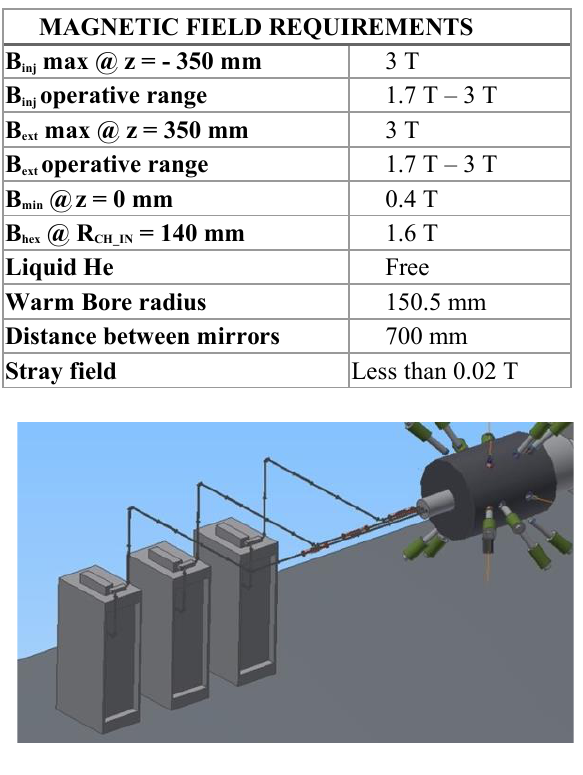
Fig. 2 – Render view of the PANDORA trap surrounded by HPGe detectors, showing the three Klystrons used to produce the high-power RF (18+21 GHz) and the corresponding microwave branching (waveguides) needed to generate the plasma via